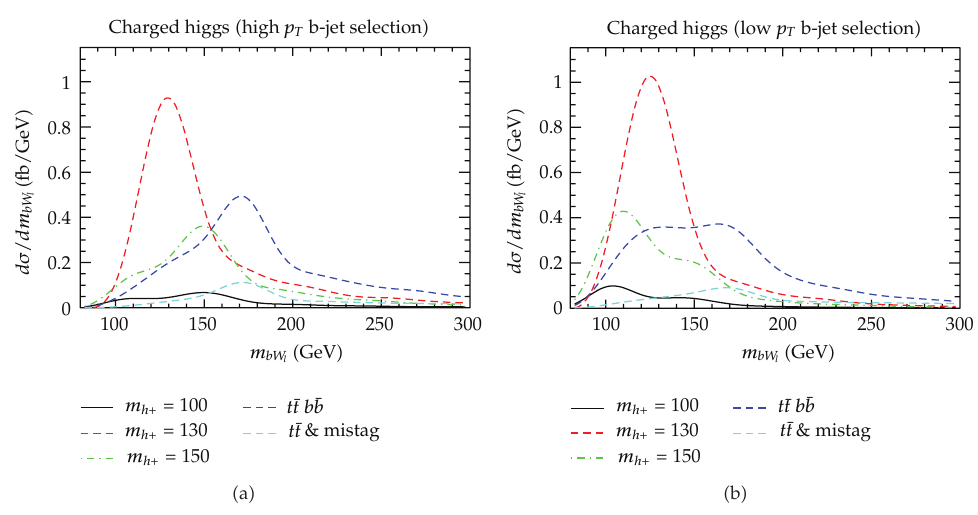
Figure 9: Reconstructed charged Higgs masses, using either the higher- p ⊥ (cid:2) a (cid:3) or the lower- p ⊥ (cid:2) b (cid:3) b -jet combined with the leptonically decaying W . √ Table 3: The S/ B ratios obtained for an integrated luminosity of 20fb − 1 for the di ff erent signals considered together with the branching ratios for the total decay chain t → bh (cid:8) → ba 1 W → bbbW of the respective parameter points and a linear extrapolation to the critical branching ratio necessary for a 5 σ